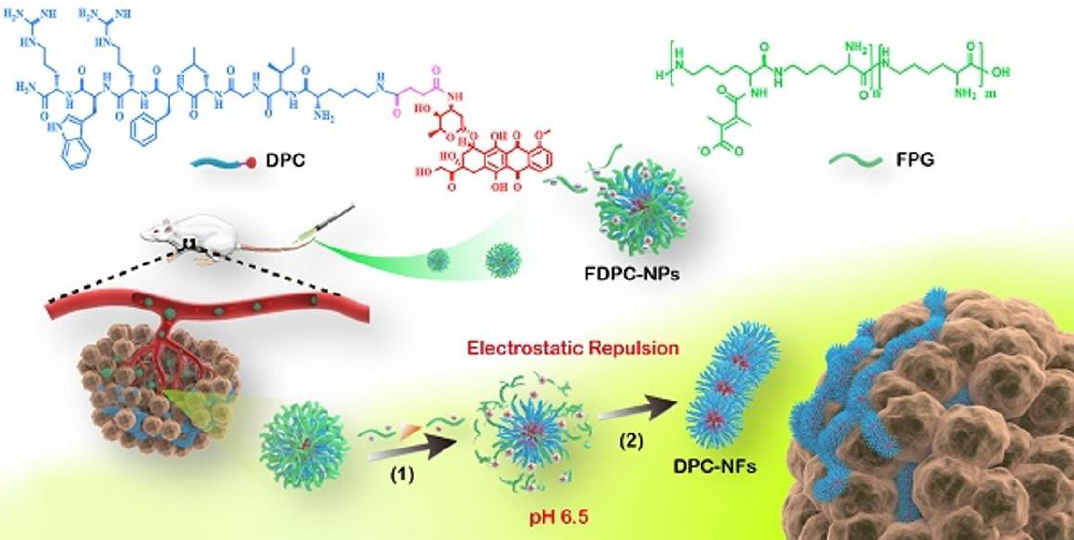
Figure 2. The self-assembly of Dox-polypeptide conjugates (FDPC-NPs) and the morphologic transformation of the acid-responsive FDPC-NPs in vitro and in vivo. Change in tumor site pH causes disintegration of micelle shell (1) and subsequent assembly of nanofibers (2) driven by π–π stacking, leading to long-term drug retention in the tumor [27]. Reprinted with permission from [27], Copyright 2022, Ivyspring International Publisher.